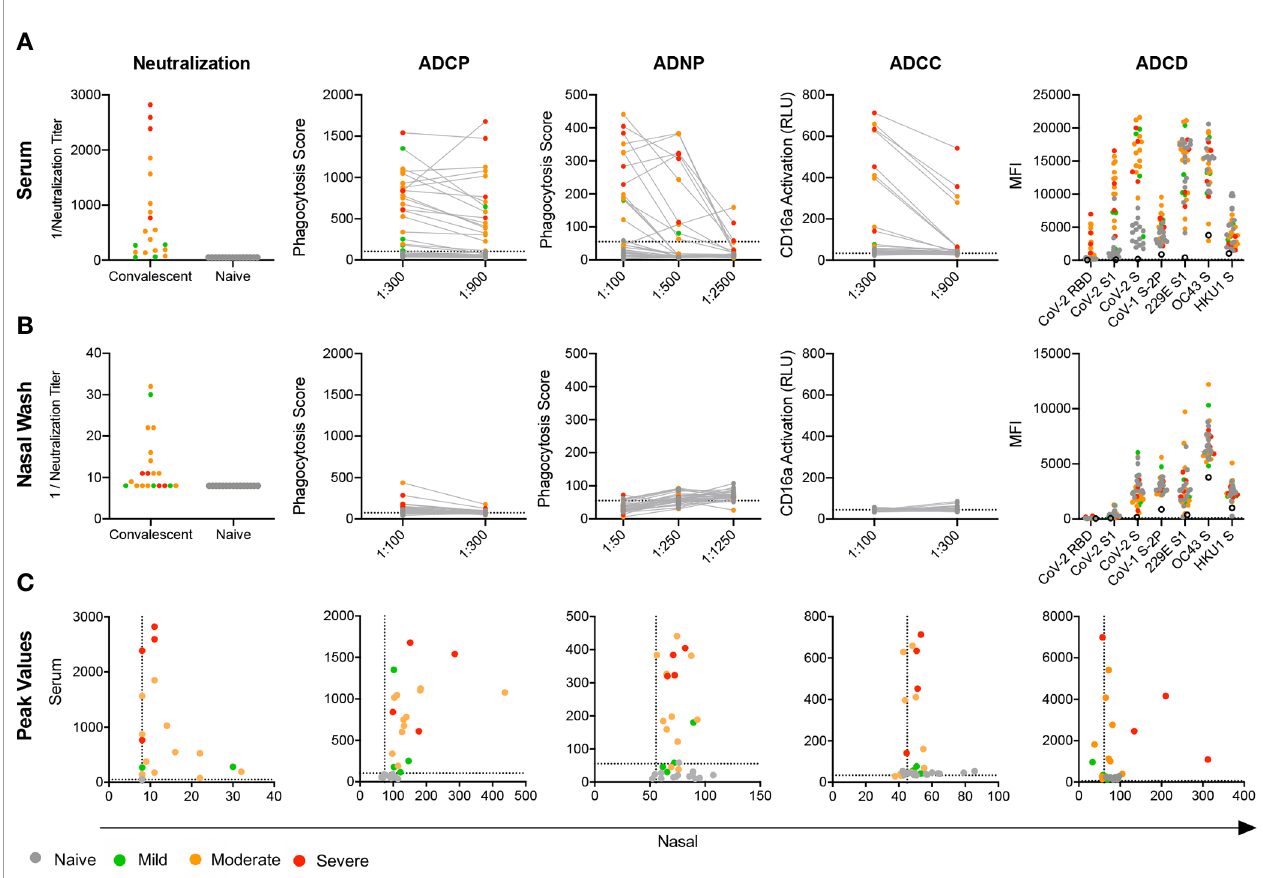
FIGURE 2 | Mucosal and systemic Ab functions. (A, B) Functional activity of serum (A, B) nasal wash subject samples in a panel of neutralization and effector function assays including antibody-dependent phagocytosis by monocytes (ADCP) and neutrophils (ADNP), action of Fc g RIIIA (ADCC), and complement cascade C3b deposition (ADCD). (C) Scatterplots of serum versus nasal wash sample activities observed for each subject for viral neutralization and RBD-speci fi c Ab effector functions. Titer is plotted for neutralization data and peak activity is plotted for effector functions. Infection status and disease severity is indicated in color. Limit of detection (neutralization) or values observed for no Ab controls (ADCP, ADNP, ADCC) are indicated with dotted lines. No Ab controls for ADCD are indicated with the hollow black